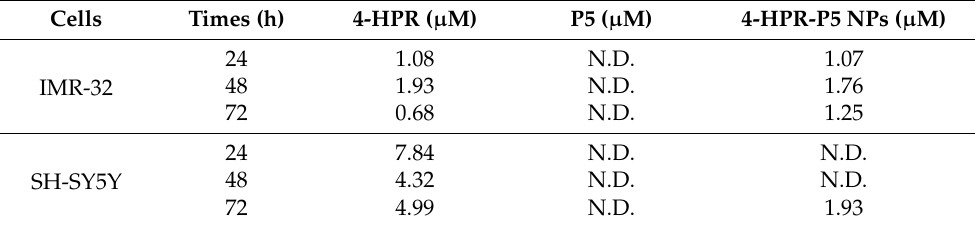
Table 3. IC50 of 4-HPR, P5, and 4-HPR-P5 NPs for IMR-32 and SH-SY5Y NB cells at 24, 48, and 72 h.